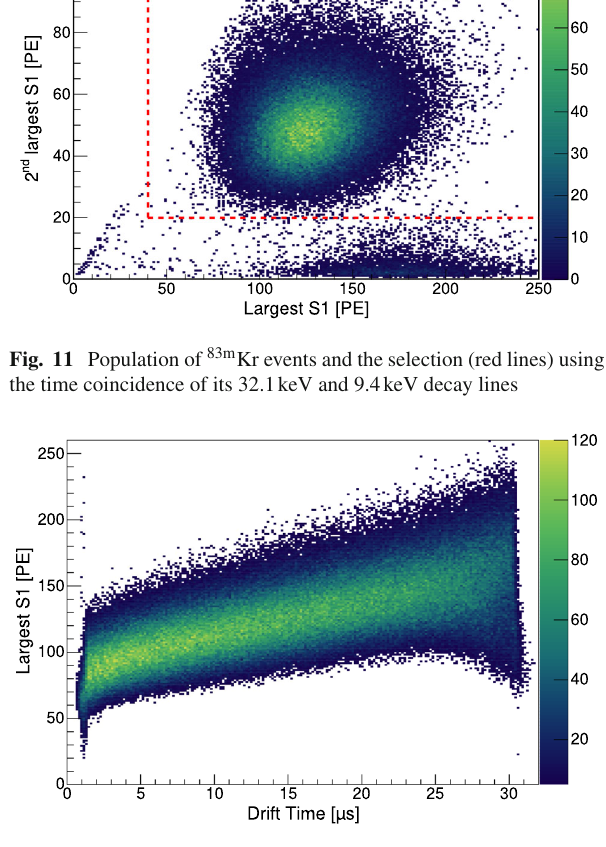
Fig. 12 Dependence of the 32.1keV S1 from 83m Kr on the drift